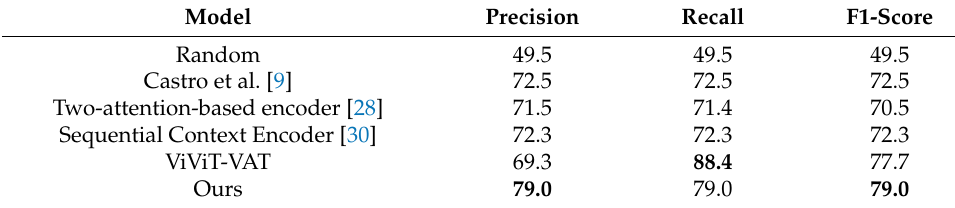
Table 4. Sarcasm detection results of different